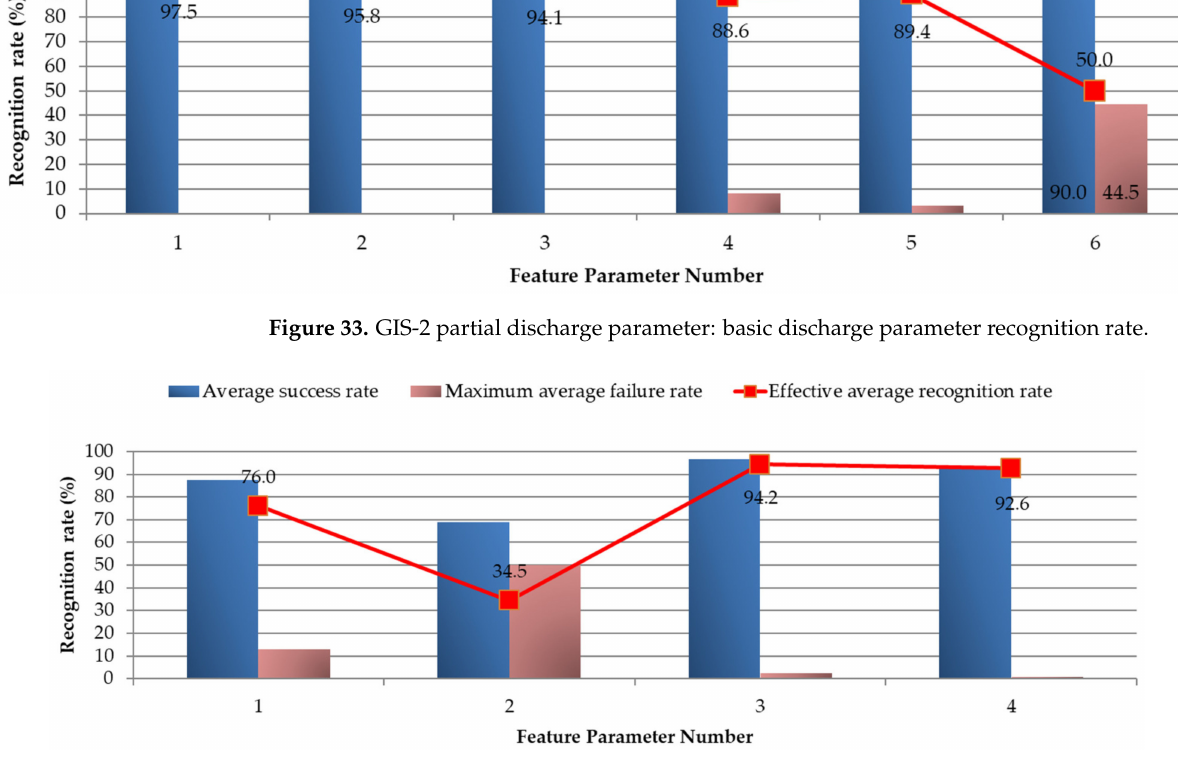
Figure 34. GIS-2 Partial discharge parametric: cross-correlation coefficient recognition rate.